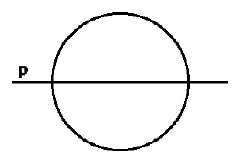
Figure 3. Massless